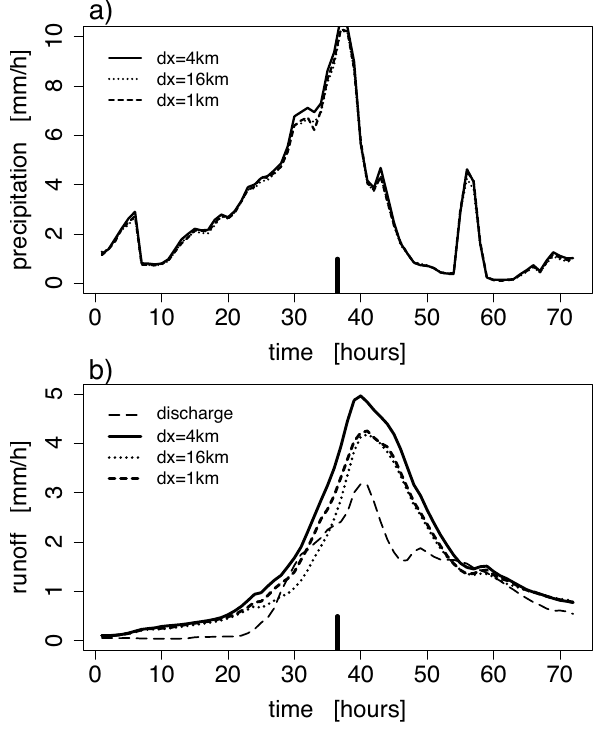
Fig. 8. Same as Fig. 5, but showing results with ALADIN-VIENNA precipitation products: raw forecast with 10km, spatially aggre- gated forecast with 40km, and downscaled forecast with 1km grid spacing.